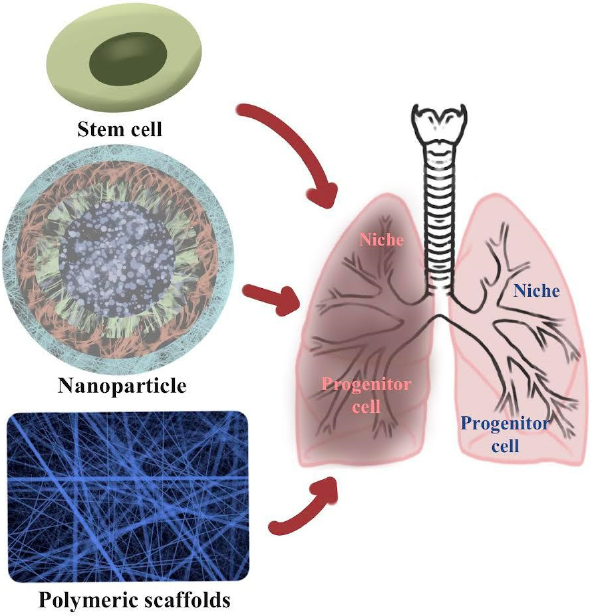
Figure 1. The effects of stem cells, nanoparticles, and biobiopolymeric